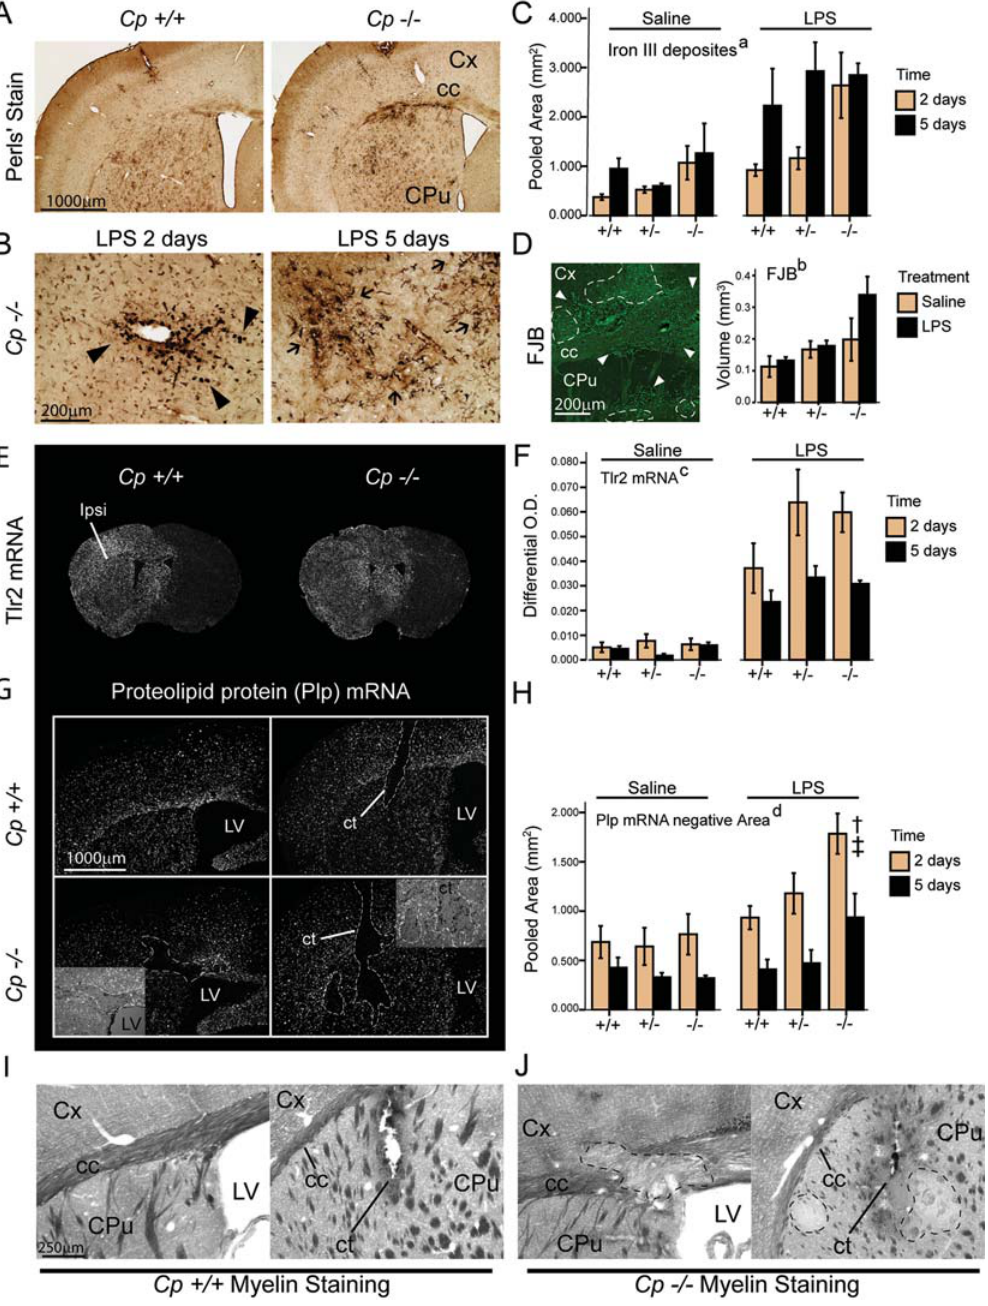
Figure 6. Ceruloplasmin regulates brain iron levels during inflammation and confers neuroprotection. (A) Cp + / + , + /- or -/- mice were sacrificed 2 days after LPS infusion and brain sections stained for Iron III (Perls’ staining). (B) High magnification of iron labeling (representative brain sections from Cp -/-mice sacrificed 2 or 5 days after LPS infusion). (C) Surface analysis to determine extent of iron deposition. (D) Fluoro-Jade B (FJB) staining was performed in brain sections from Cp + / + , + /- and -/- infused with LPS or saline. Volumetric analysis was performed by stereological procedure. (E) Representative dark-field picture of adjacent brain sections hybridized with Tlr2 cRNA probe in LPS treated mice 2 days after infusion. (F) Semi- quantitative analysis of Tlr2 mRNA hybridization signal. (G) Representative sections hybridized with Plp cRNA riboprobe to detect regions lacking signals (demyelinated area). These panels show two different coronal levels (cannulae track level and a section distal to the site of injection). (H) Surface analysis of demyelinated area. (I) and (J) are representative microphotographs of Sudam Black B (SBB) stained sections from Cp + / + and -/- mice sacrificed 2 days after LPS infusion, as indicated. Statistical analysis was performed via a two or three-way ANOVA followed by a Bonferroni’s multiple comparison test when applicable. ‘‘a’’, significant genotype effect (p , 0.05), significant time effect (p , 0.01), significant treatment effect (p , 0.001), Cp -/-significantly different from Cp + / + (p , 0.01) and Cp + /- (p , 0.05). ‘‘b’’, significant genotype effect (p , 0.01), Cp -/- statistically different from Cp + / + (p , 0.005). ‘‘c’’, significant interaction between treatment and time factors (p , 0.01), LPS treatment 2 days statistically different from LPS 5 days (p , 0.001). ‘‘d’’, significant interaction between treatment and genotype effect (p , 0.05), significant time effect (p , 0.001), in the LPS treated group Cp -/- was statistically different from Cp + / + ( { p , 0.005) and from Cp + /- ( { p , 0.01). Abbreviations: cc, corpus callosum; CPu, caudate putamen; ct, cannulae track; Cx, cortex; LV, lateral ventricle.